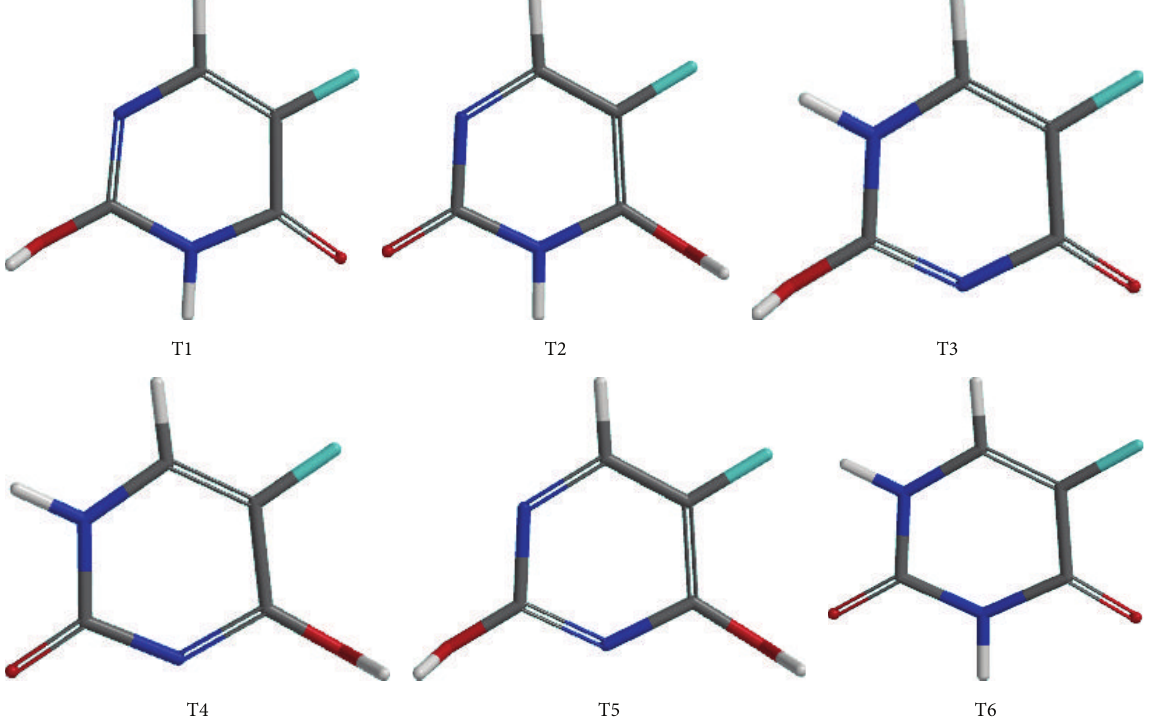
Figure 8: The six possible tautomers of